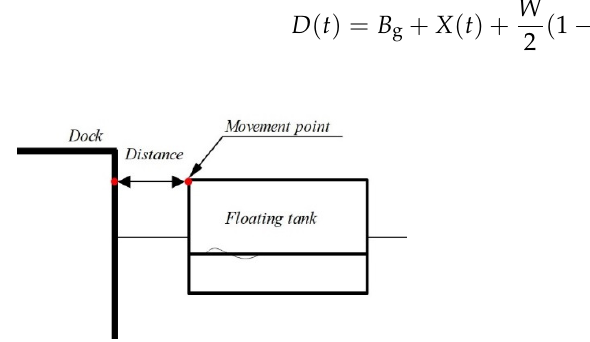
Figure 7. Movement tracks and distance between floating tank and dock of four different resonance conditions. ( a ) The coupled resonance of sloshing and the narrow gap in case 2-5; ( b ) the sloshing resonance in case 2-6; ( c ) the narrow gap resonance in case 2-1; ( d ) the non-resonance in case 2-2. The red and blue lines represent the position of the dock and the still water level surface, respectively.